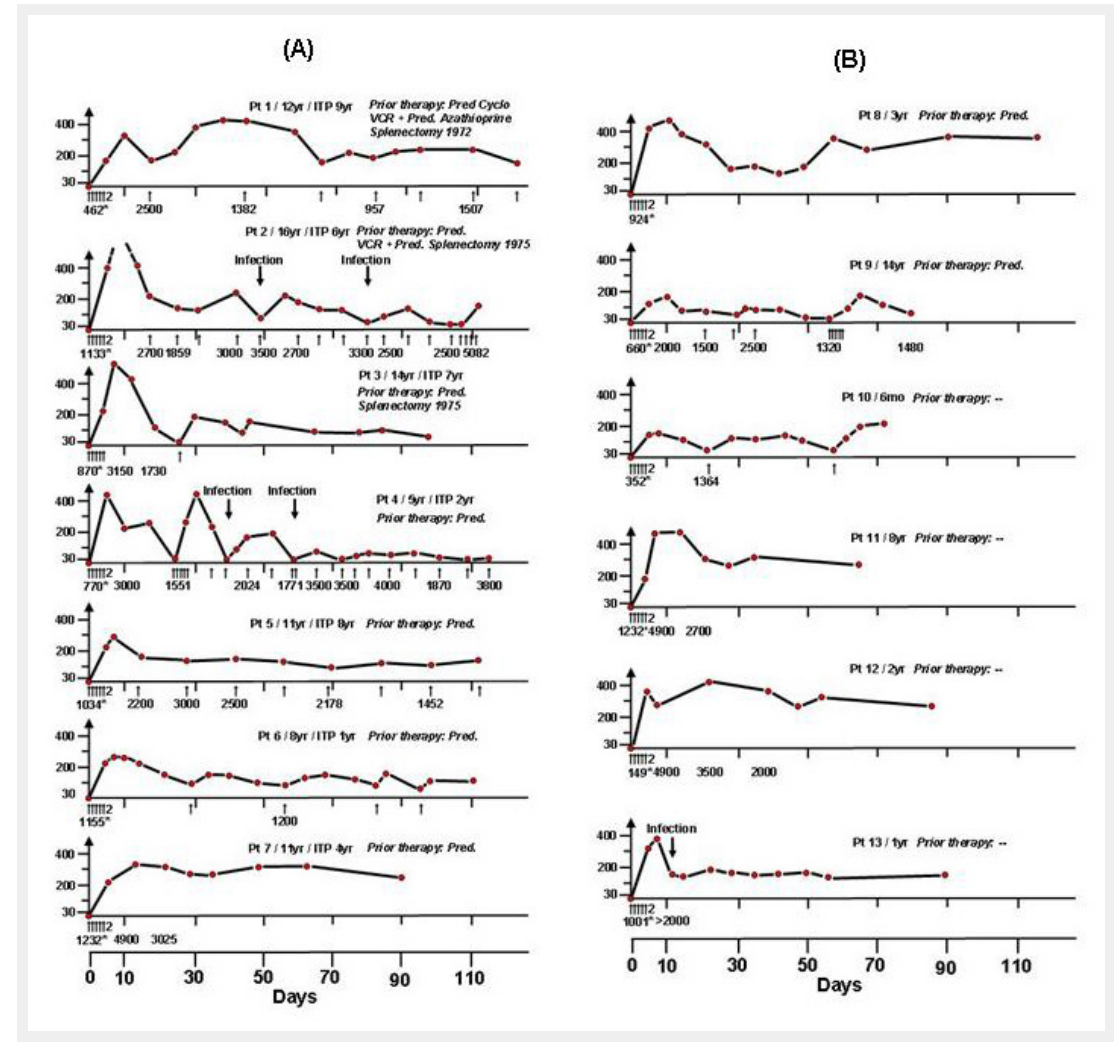
Figure 2 Pilotstudy 2: (A) 7 patients with chronic or intermittent ITP, (B) 6 patients with newly diagnosed ITP. All, consecutive patients with primary ITP demonstrated increases of platelet counts. Arrows indicate IVIG 0,4 g/kg body weight/day (© Imbach P, Barandun S, d’Apuzzo V, Baumgartner C, Hirt A, Morell A, et al. High-dose intravenous gammaglobulin for idiopathic thrombocytopenic purpura in childhood. Lancet. 1981;1:1228–31. Reprinted with kind